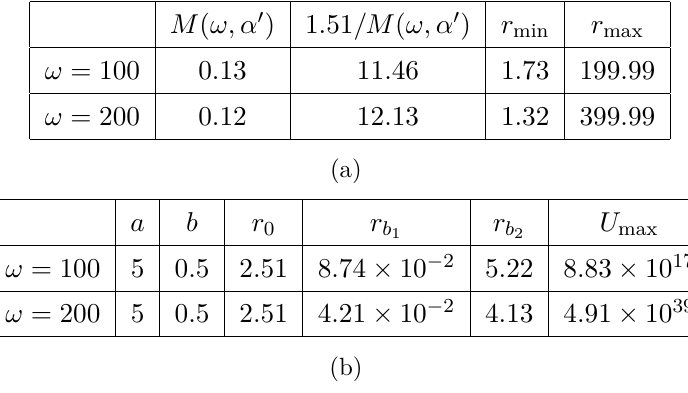
Table 1 . Examples of parameters that satisfy the condition for having bound